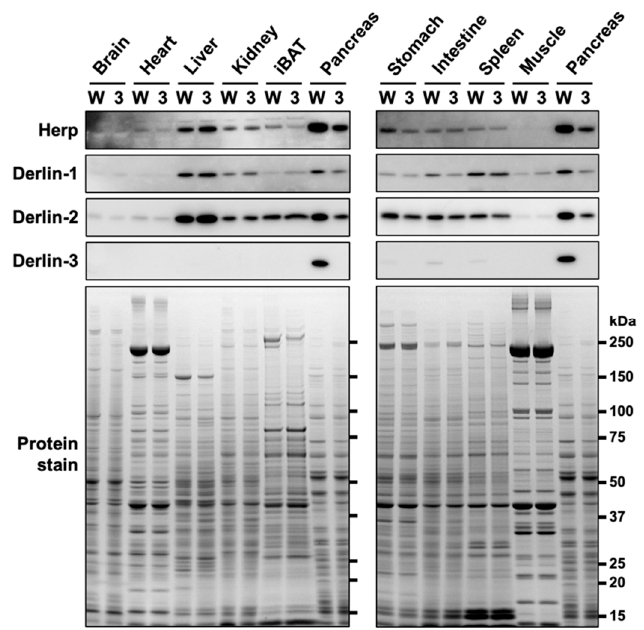
Figure 1. Protein expression patterns in mouse organs. Wild-type (WT) (W) and Derlin-3-deficient (3KO) (3) mice were fasted for 12 h before euthanasia, and organ homogenates were subjected to a Western blotting analysis using antibodies indicated on the left side. Bottom images (Protein stain) show protein bands in the gel stained with GelCode Blue Stain Reagent to check for equal loading. iBAT, interscapular brown adipose tissue.